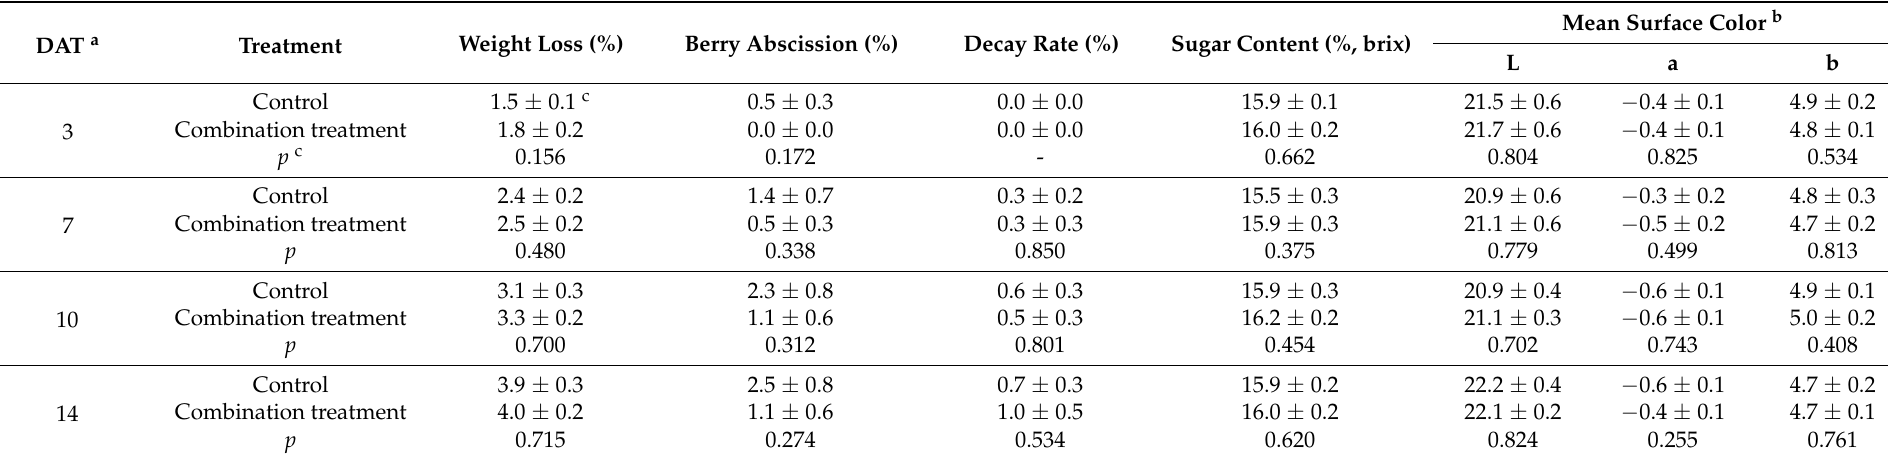
Table 4. Phytotoxicity of the combined treatment to grapes at a 15% loading ratio in a 0.65 m 3 fumigation